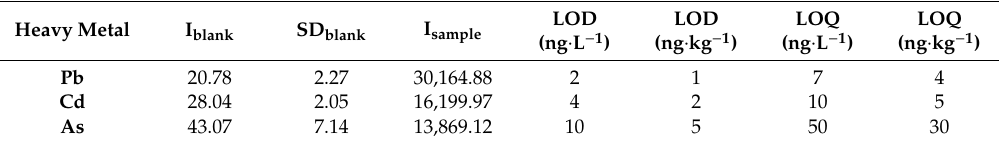
Table 3. The LOD and LOQ of Pb, Cd and As.